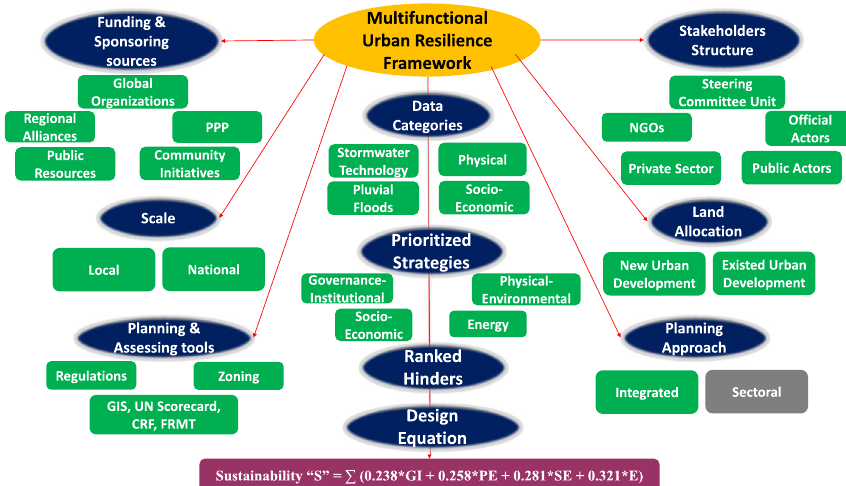
Fig. 12 Proposed multifunctional urban resilience